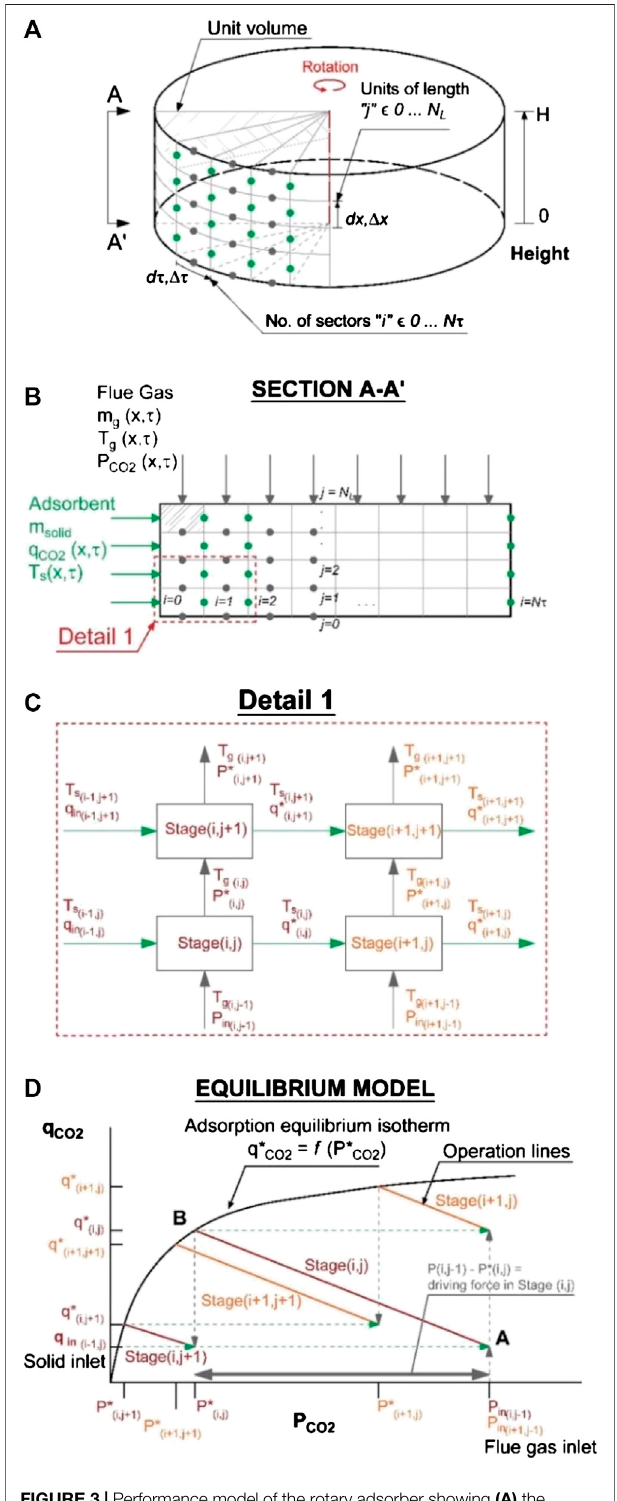
FIGURE 3 | Performance model of the rotary adsorber showing (A) the divisionoftheequilibriummodelintocells, (B) thecross- fl owarrangement, (C) the equilibrium stages, and (D) the operational lines and the equilibrium